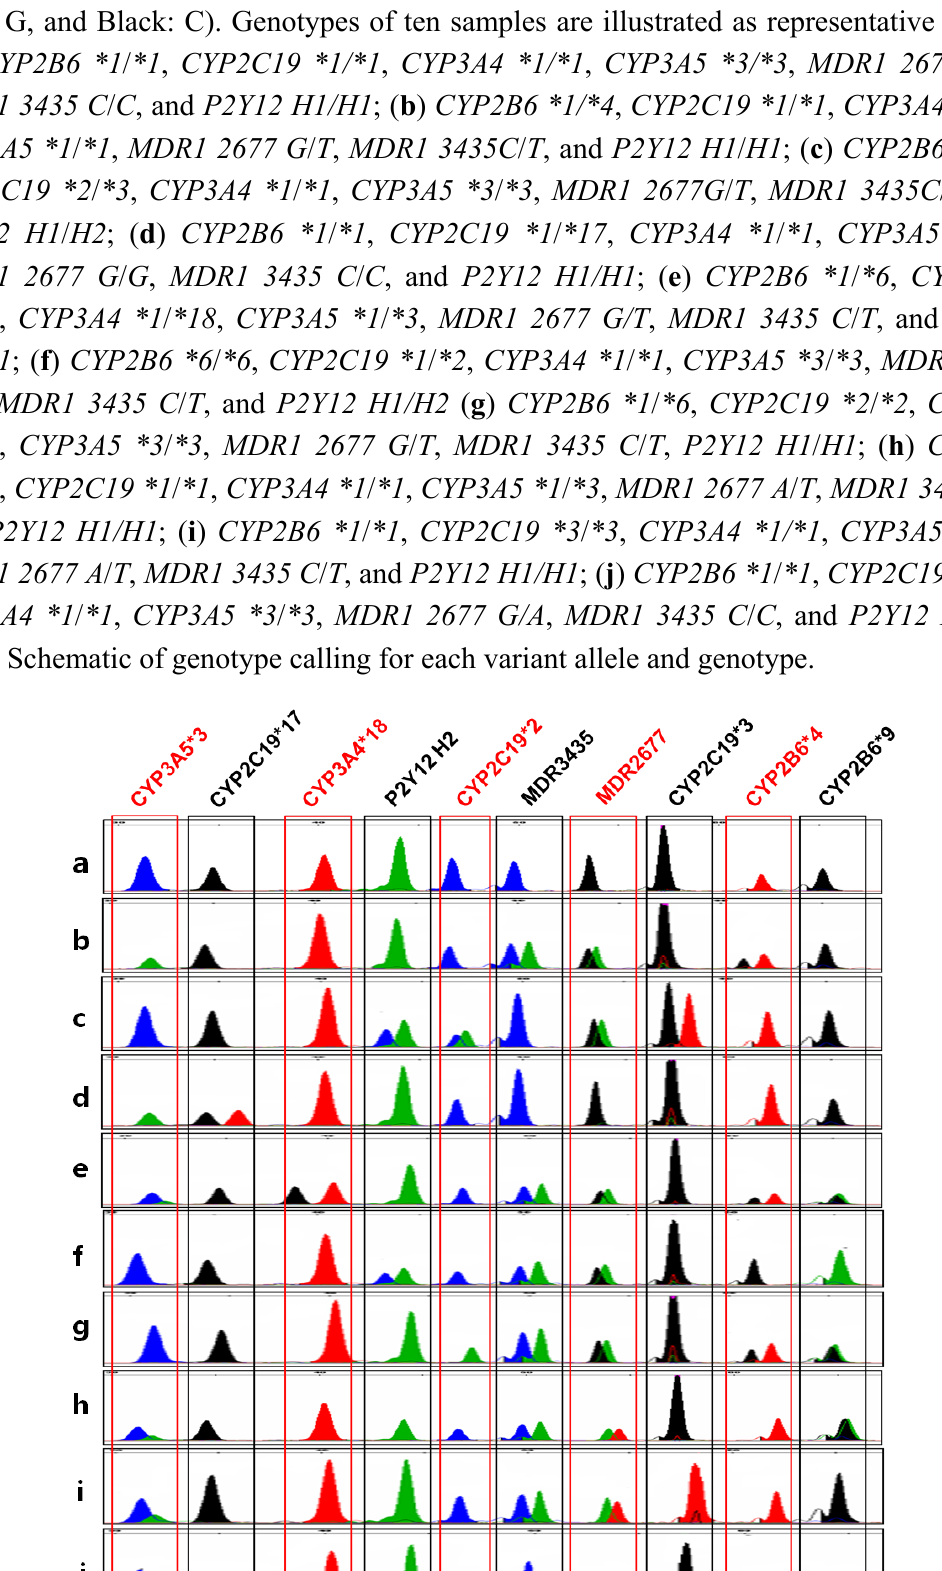
Figure 1. ( A ) Representatives of electropherograms obtained from multiplex single-base extension. The detected variant alleles are shown above the peaks (Green: A, Red: T, Blue: G, and Black: C). Genotypes of ten samples are illustrated as representative